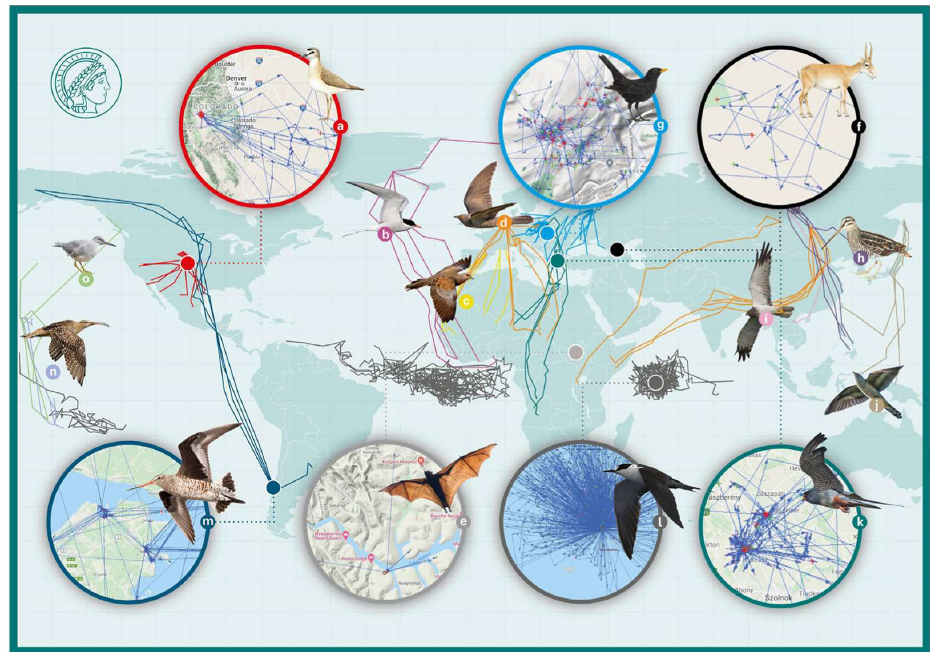
Figure 19. Overview of first ICARUS data. The global map displays large-scale tracks of selected individuals of 15 species (a–o); the inset maps show regional-scale tracks of seven species during this period. Map redrawn from Jetz et al. 2022 [1], with permission.